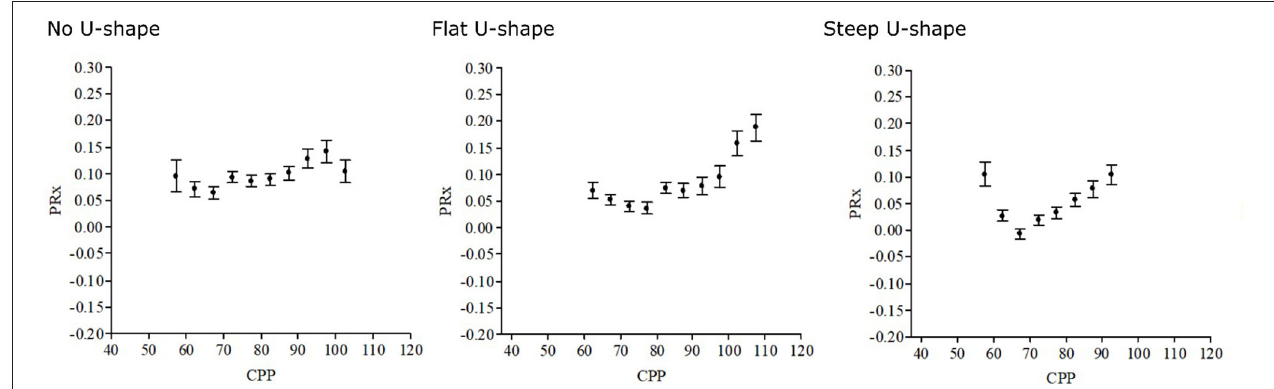
FIGURE 3 | Optimal cerebral perfusion pressure (CPPopt)—differences in curve shape. The CPPopt curves may vary over time and between patients, as illustrated in these three different curves. There are questions on how the curve shape and the absolute pressure reactivity index (PRx) are relevant in CPPopt management. Patients with a steeper CPPopt curve may, in theory, be more vulnerable to changes in CPP.